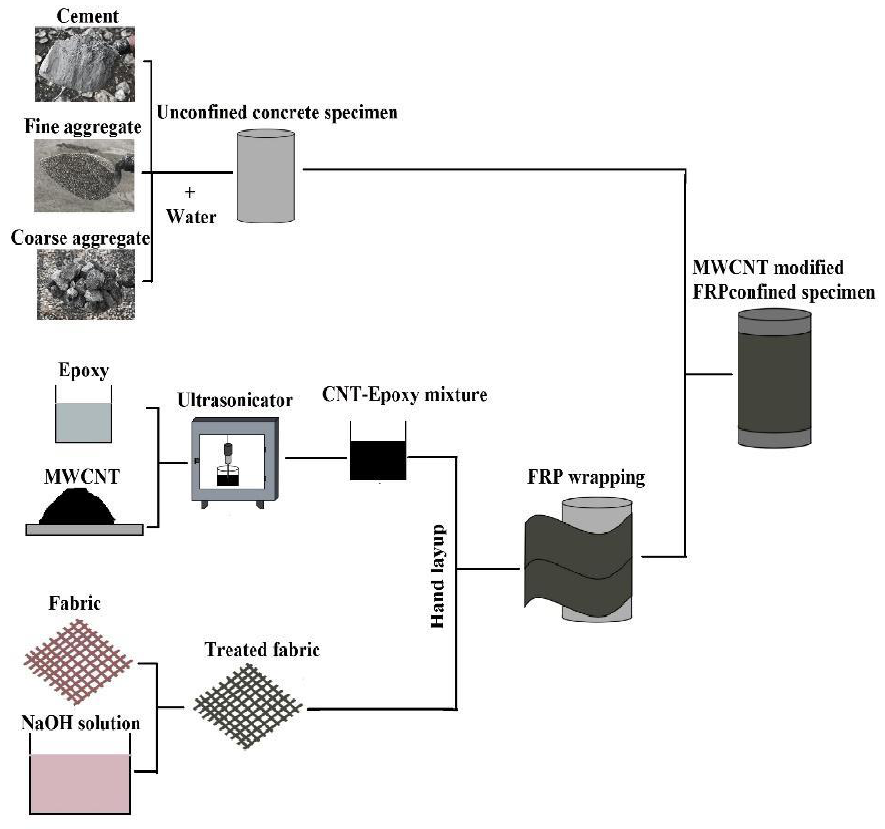
Figure 2. Schematic representation of the preparation of FRP confined specimens. Table 2. Specimen details and nomenclature.